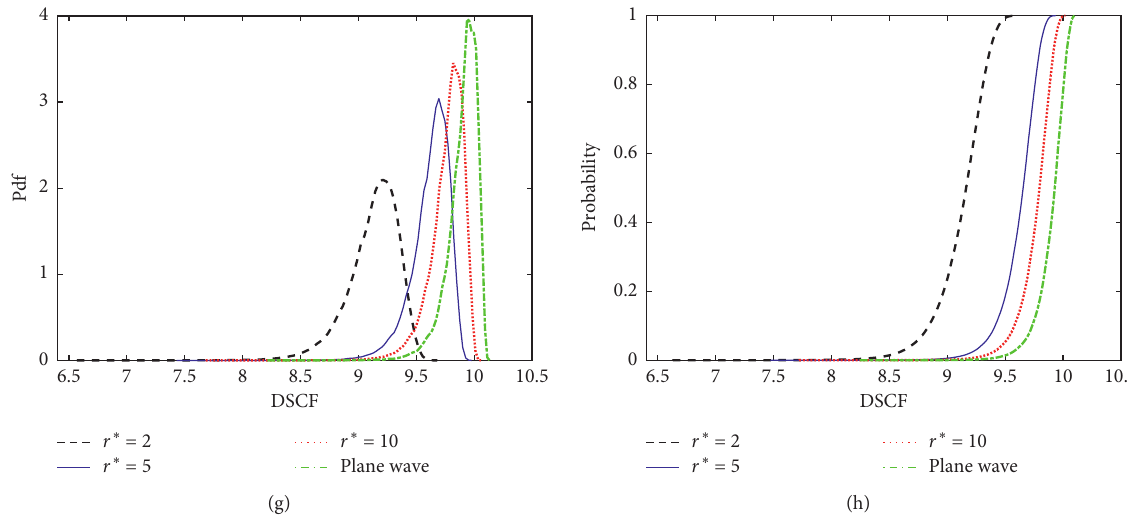
Figure 5: PDF curves (left) and CDF curves (right) of DSCF when δ f � 50Hz; (e) PDF f � 100Hz; (f) CDF f � 100Hz; (g) PDF f � 200Hz; (h) CDF f �